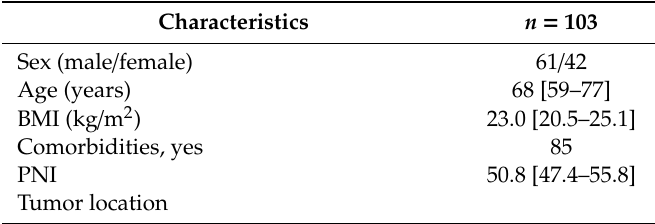
Table 1. Patient